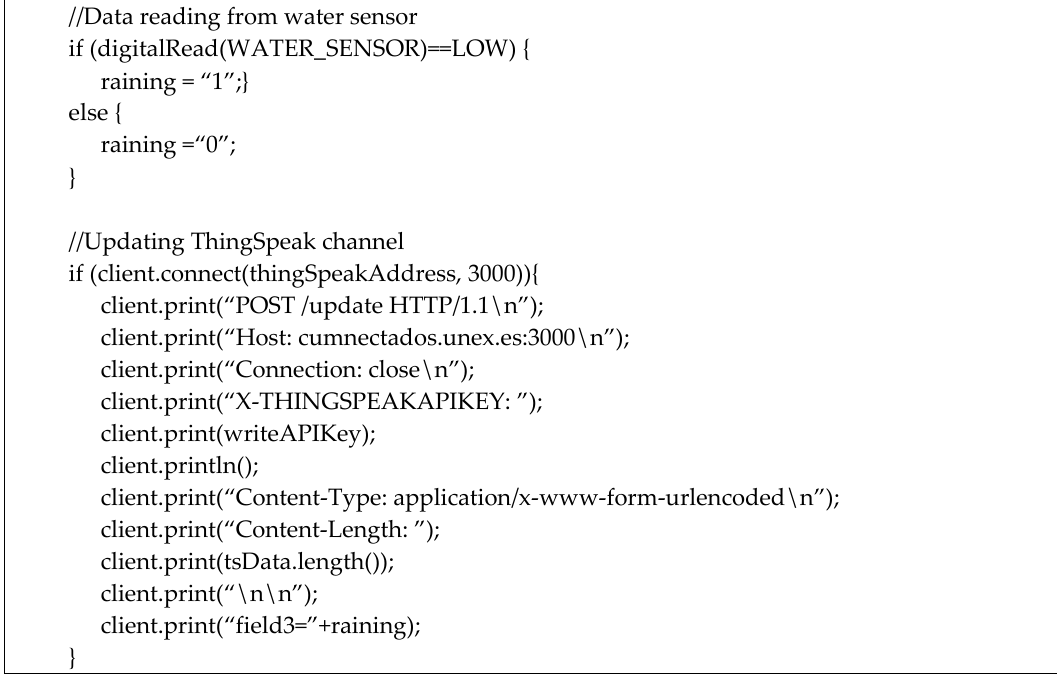
Figure 6. Logic layer update from Arduino (Rain sensor).